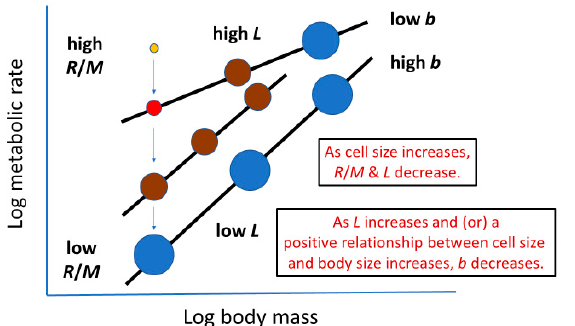
Figure 7. Schematic representation of how cell size (depicted by sizes of circles) may affect R / M (metabolic rate of an individual organism or species at a specific body mass), L (metabolic level or log mass-specific metabolic rate at the midpoint of the log body-mass range; as such, this measure represents the vertical elevation of a metabolic scaling relationship) and b (the loglinear slope of the scaling relationship). Note that all of the effects depicted are logically consistent and thus compatible with each